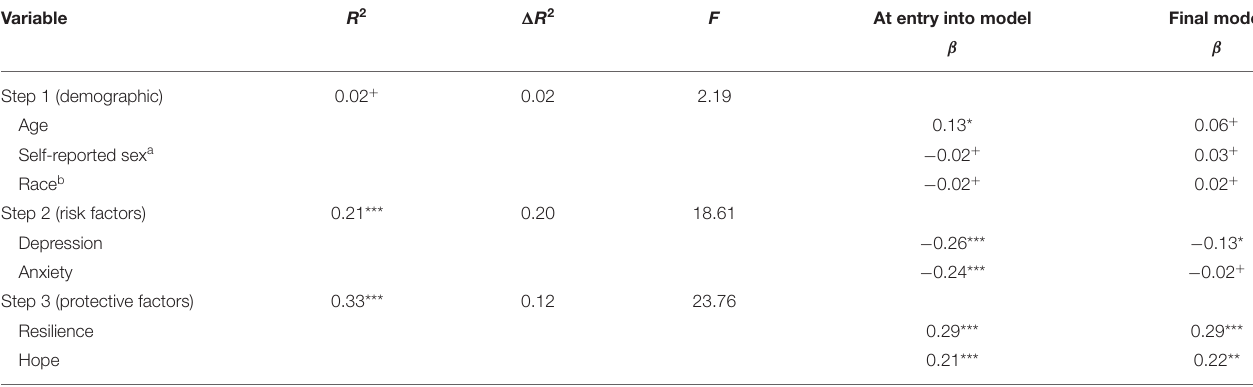
TABLE 2 | Hierarchical regression analysis for prediction of grit (N =